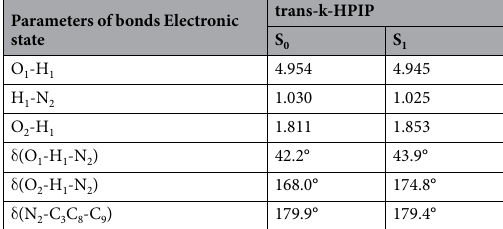
Table 3. The bond parameter (bond length (Å), length angle (°) and dihedral angle (°)) of crucial moiety for the trans-k-HPIP in the S 0 and S 1